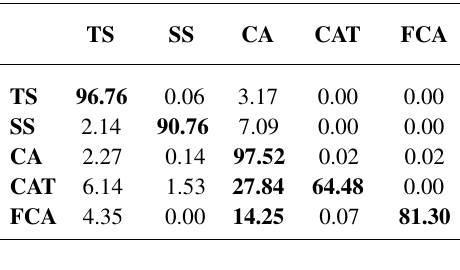
Table 9. Confusion matrix August 2018